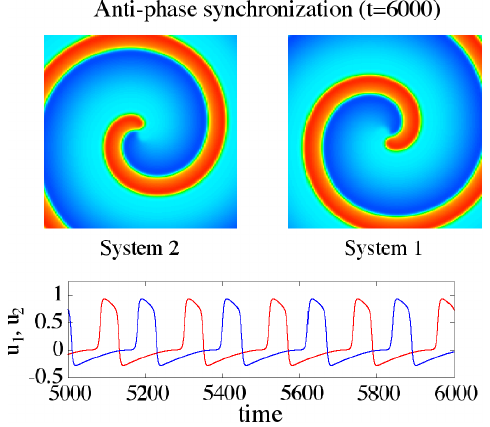
VIDEO 6. Antiphase synchronization of rotating spirals. The parameters are the same as in Fig. 4 except for K ¼ diag ð k ¼ 5 × 10 − 4 ; 0 Þ . The initial phase difference is ϕ ð 0 Þ ¼ 1 . 44 . The bottom figure shows the evolution of the activator variables ð u 1 ; u 2 Þ at ð x; y Þ ¼ ð L= 4 ; L= 4 Þ of both